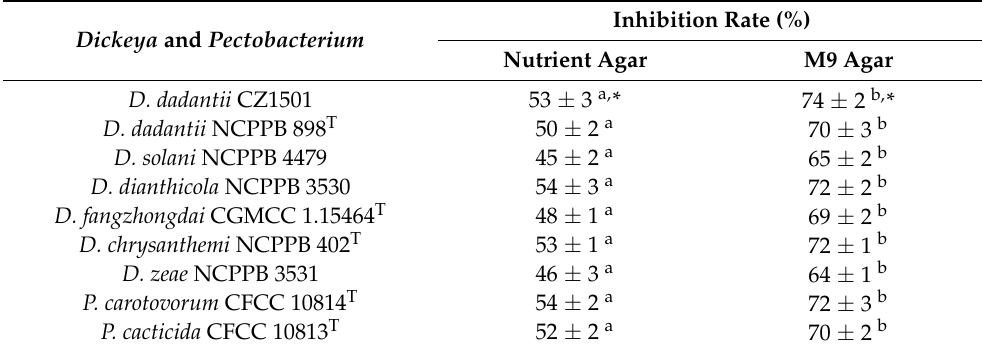
Table 3. Inhibition of Dickeya and Pectobacterium strains by P. polymyxa ShX301 based on in vitro overlay culture assays on nutrient agar and M9 minimal